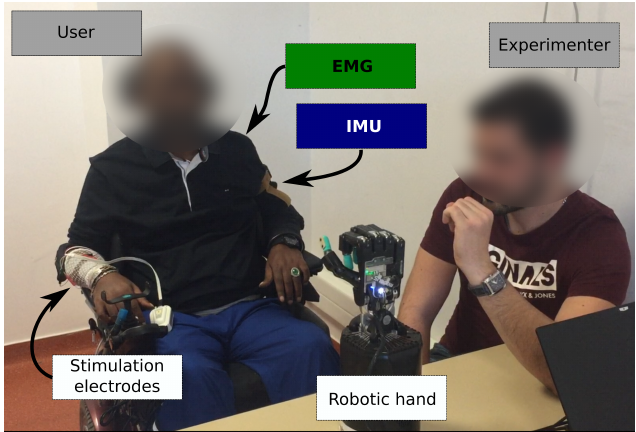
Figure 5. Setup for EMG and IMU sessions. In the validation phase, an experimenter showed the subject which gesture the robotic hand should be commanded to